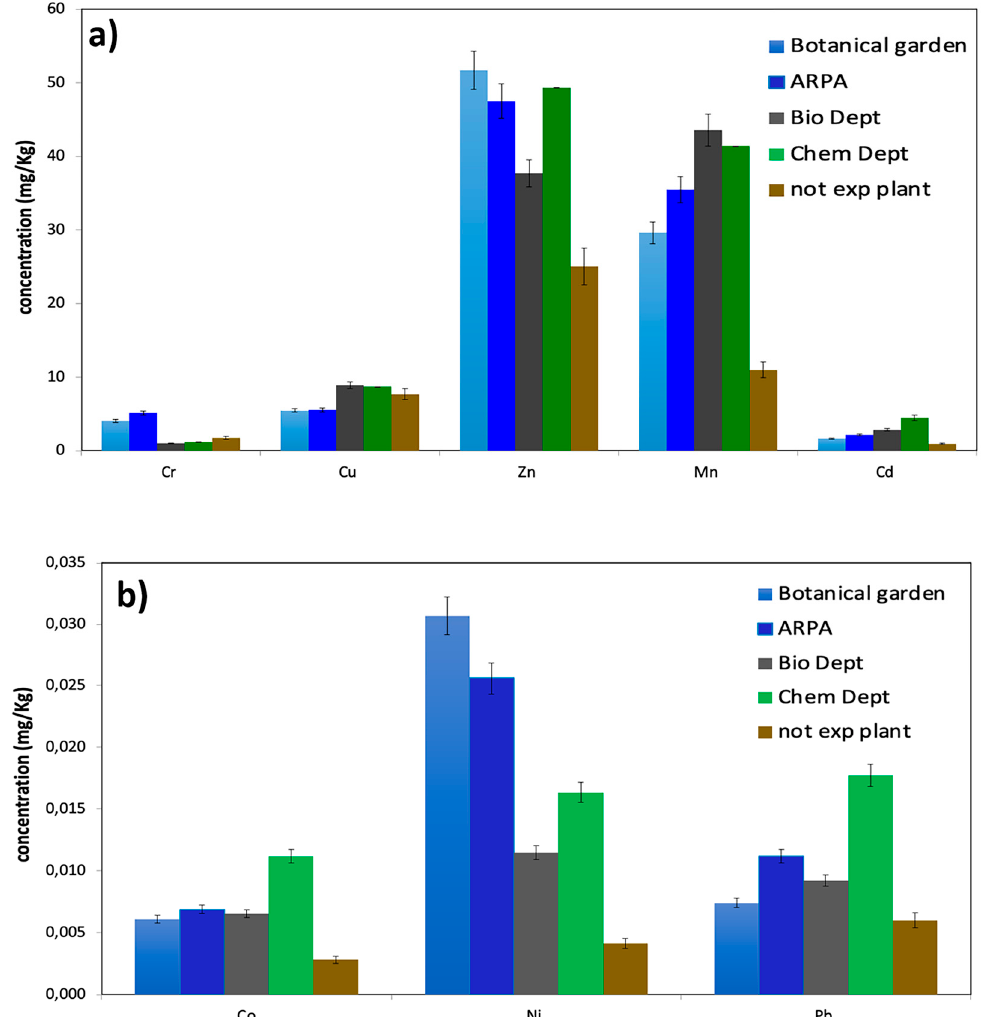
Figure 4. Concentrations trends for Cr, Cu, Zn, Mn, Cd ( a ) and Co, Ni, Pb ( b ) in the Chlorophytum comosum analyzed samples in the different sites in Milan and for an exposure time of 165 days; the metals concentrations for the not-exposed plant used as reference are also reported.